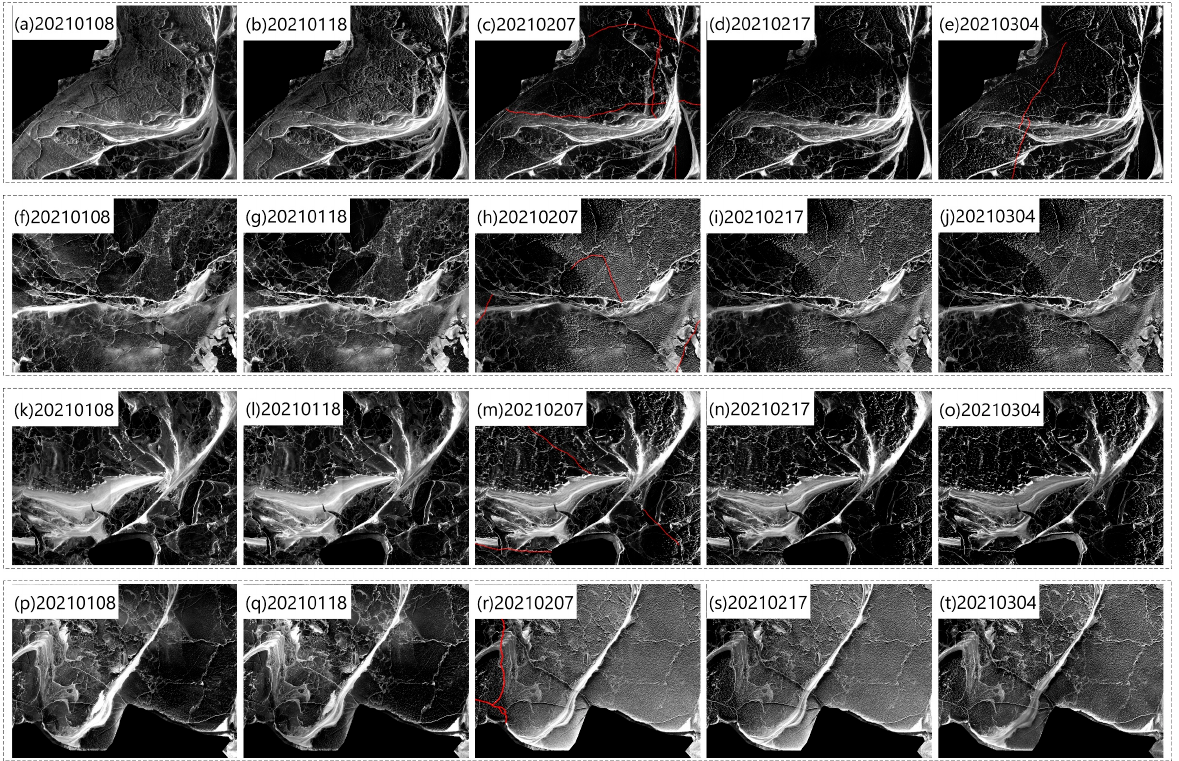
Figure 10. ( a – t ) represent the ice ridges and crevasses on the ice surface as observed through band 8 of Sentinel-2 optical remote sensing images. Red lines represent emerging or deepening crevasses.